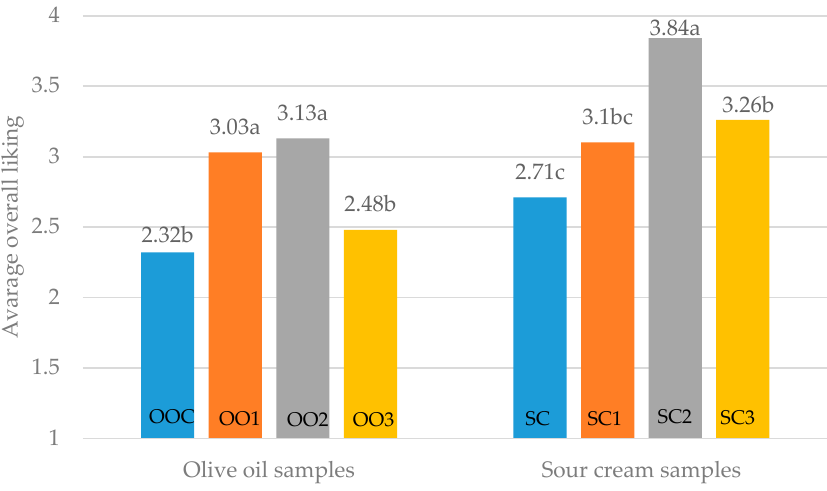
Figure 4. Overall liking of the olive oil and sour cream samples. Different letters among the samples mark significant differences ( p ≤ 0.05). Table 7. The percentage of volatile compound peak areas in the experimental samples with olive